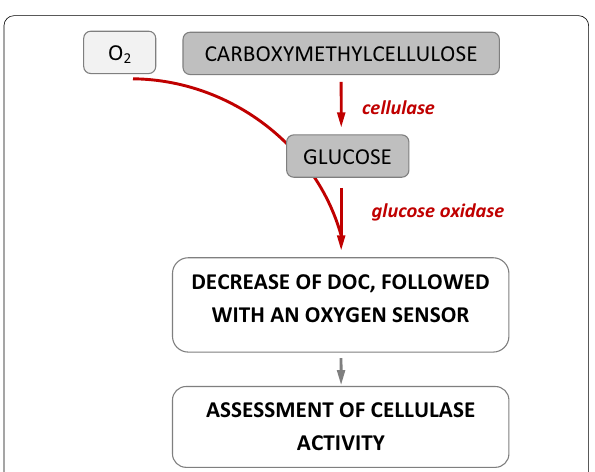
Fig. 2 The principle scheme of the amperometric assessment of cellulase